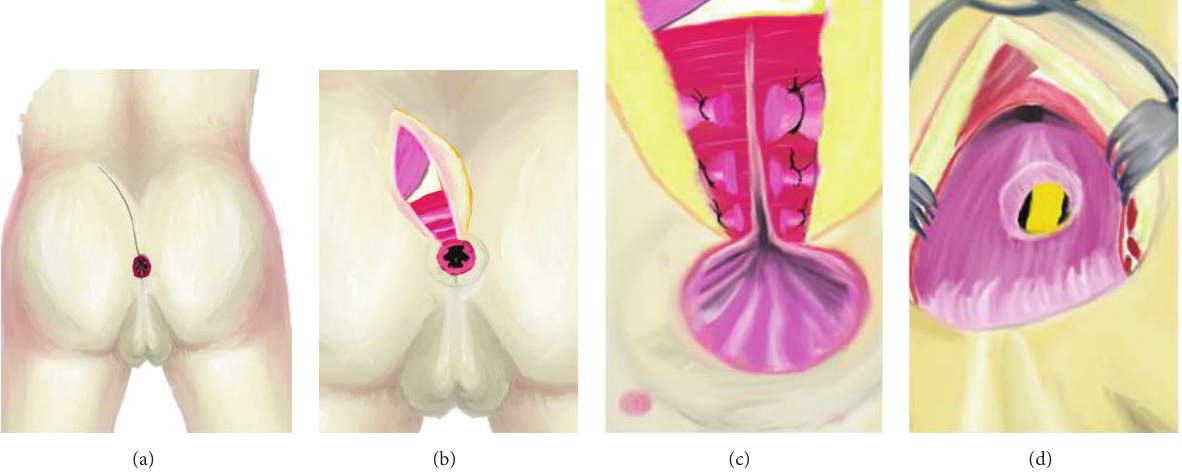
Figure 4: Schematic illustration of the picture in Figure 1 showing opening of the posterior rectal wall; it is first part of the York Mason posterior transrectal transsphincteric procedure. (a) Incision line is seen. (b) After opening skin and subcutaneous tissue, gluteus and anal sphincter muscles are seen. (c) Incised anal sphincter muscles and posterior rectal wall are seen. (d) After opening posterior rectal wall, the rectourethral fistula (RUF) and urethral catheter are